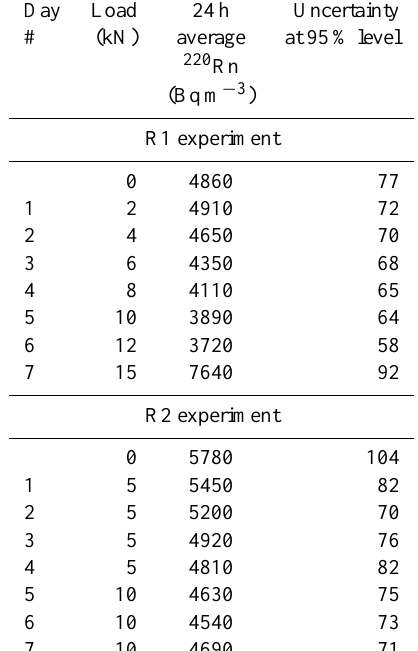
Table 1. Data set from the DDRC experiments. The 24h average 220 Rn concentrations and loading conditions are reported for R1, R2 and R3 experiments. When the load is increased up to 15kN, all TRSN samples are invariably failed. Each experiment has been replicated three times in order to test the reproducibility of the pro- cess at constant temperatures of 90 ◦